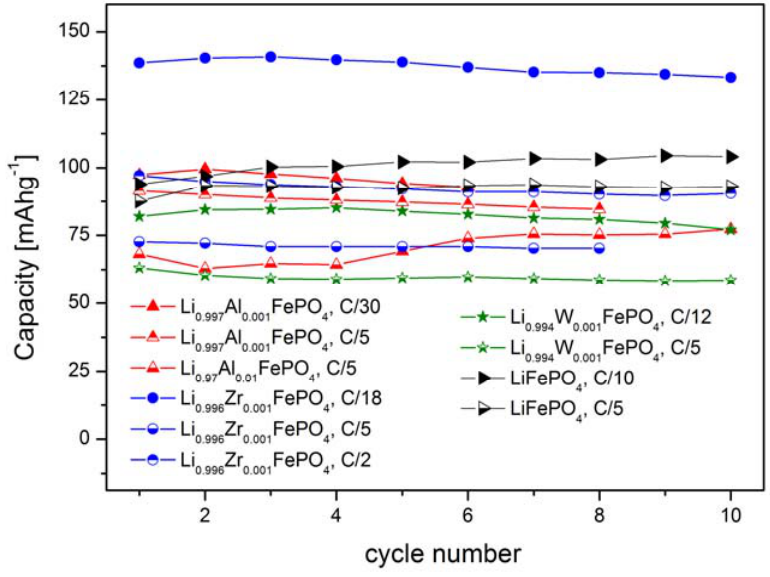
Figure 16. Reversible capacity of studied lithium cells with Li Al FePO , 0.997 0.001 4 Zr FePO , Li W FePO and Li Al FePO cathode materials as a Li 0.996 0.001 4 0.994 0.001 4 0.97 0.01 4 function of cycle number. Data obtained for different charge/discharge